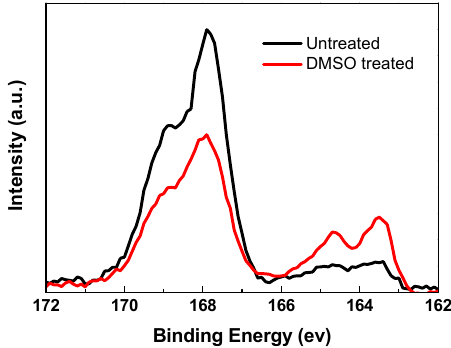
Figure 2. S 2 p XPS spectra of PEDOT:PSS films without and with solvent washing treatment.